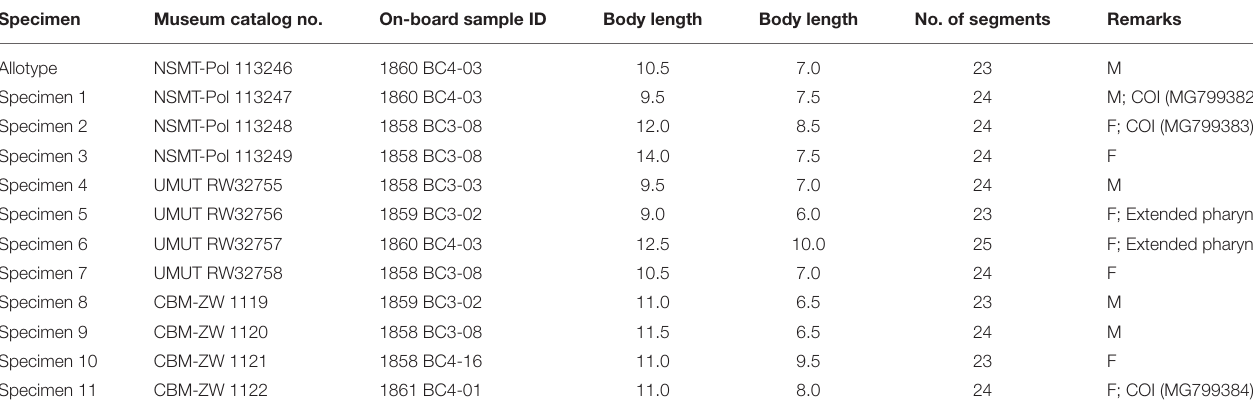
TABLE 5 | Specimens of Lepidonotopodium okinawae used in this study. Specimen